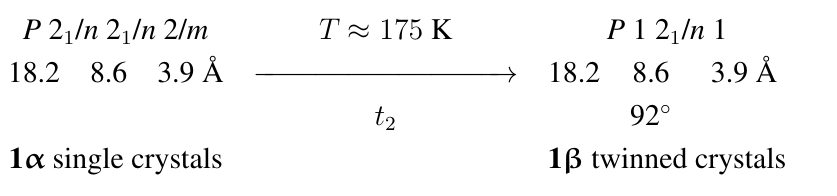
Scheme 2. Symmetry relation of high-temperature ( 1 α ) and low-temperature ( 1 β ) phase.